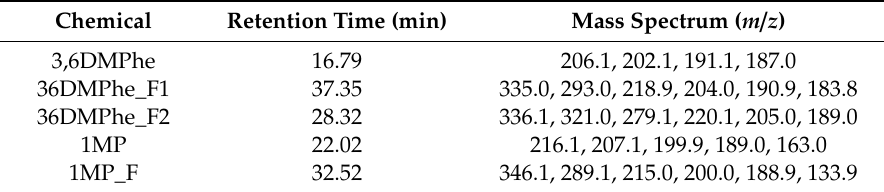
Table 2. Retention times and mass fragmentation spectrums of 3,6-dimethylphenanthrene, 1-methylpyrene, and tentatively identified metabolic products in the fractions, 3,6DMPhe_F1, 3,6DMPhe_F2, and 1MP_F. Chemical Retention Time